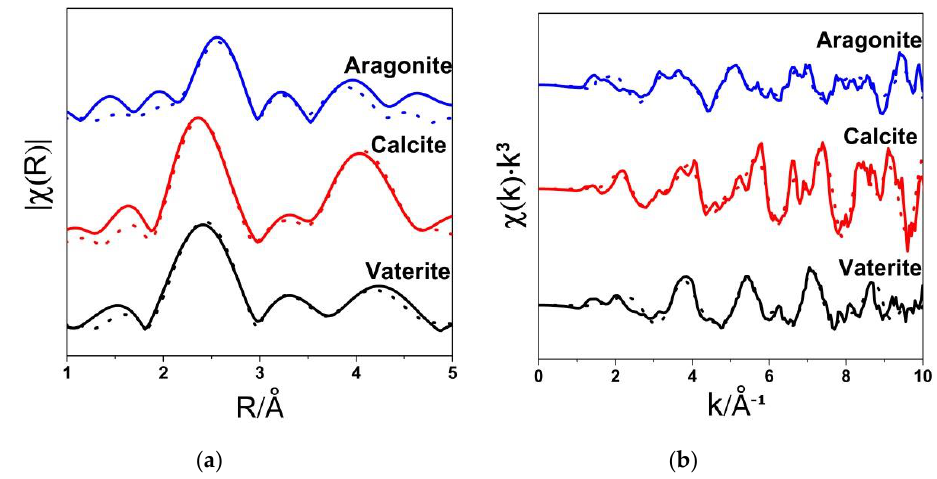
Figure A2. Ca K-edge extended X-ray absorption fine structure (EXAFS) spectroscopy of three references, vaterite, calcite, aragonite plotted in R space (Fourier transform magnitude) ( a ) and k space ( b ).